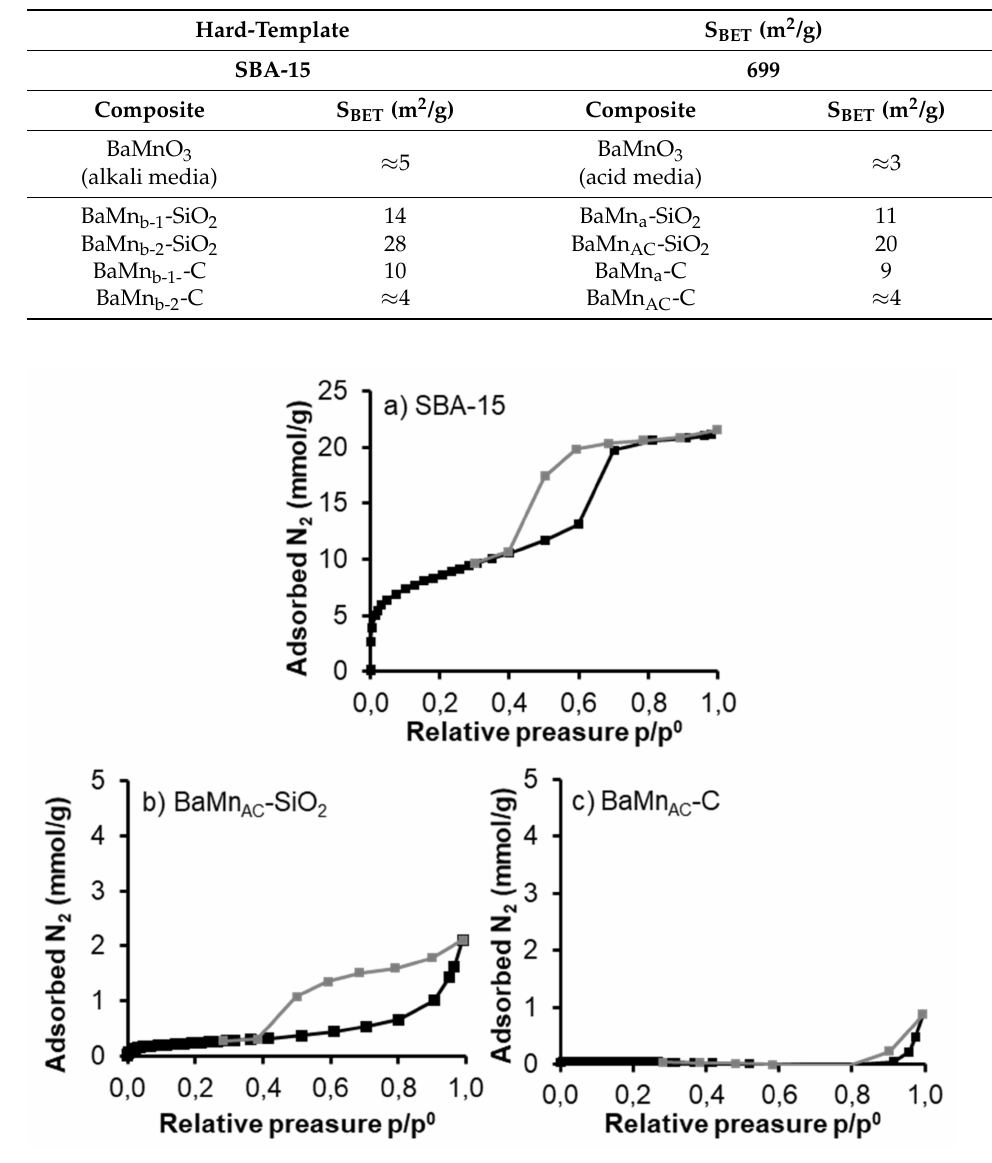
Figure A2. N 2 adsorption isotherms (adsorption in black and desorption in grey) of: ( a ) the synthe- sized hard template (SBA-15), ( b ) the hybrid material obtained by citric acid excess route (BaMn AC - SiO 2 ), and ( c ) the corresponding final solid after silica removal and calcination step (BaMn AC -C). Figure A3 presents the X-ray patterns for the samples in different steps of the synthesis routes indicated in Table A1. The X-ray patterns show the range from 20 ◦ to 36 ◦ 2 θ values because the main peak of BaMnO 3 hexagonal perovskite is located at c.a. 31.4 ◦ . Note that all the non-assigned diffraction peaks (which hinders the interpretation of the X-ray patterns) correspond to several barium silicates and that the samples obtained by the synthesis in alkali media (b1 and b2) show a higher amount of barium silicates because silica is less stable at high pH values. Thus, it is concluded that any of the synthesis procedures used allow the formation of the perovskite structure as the main crystal